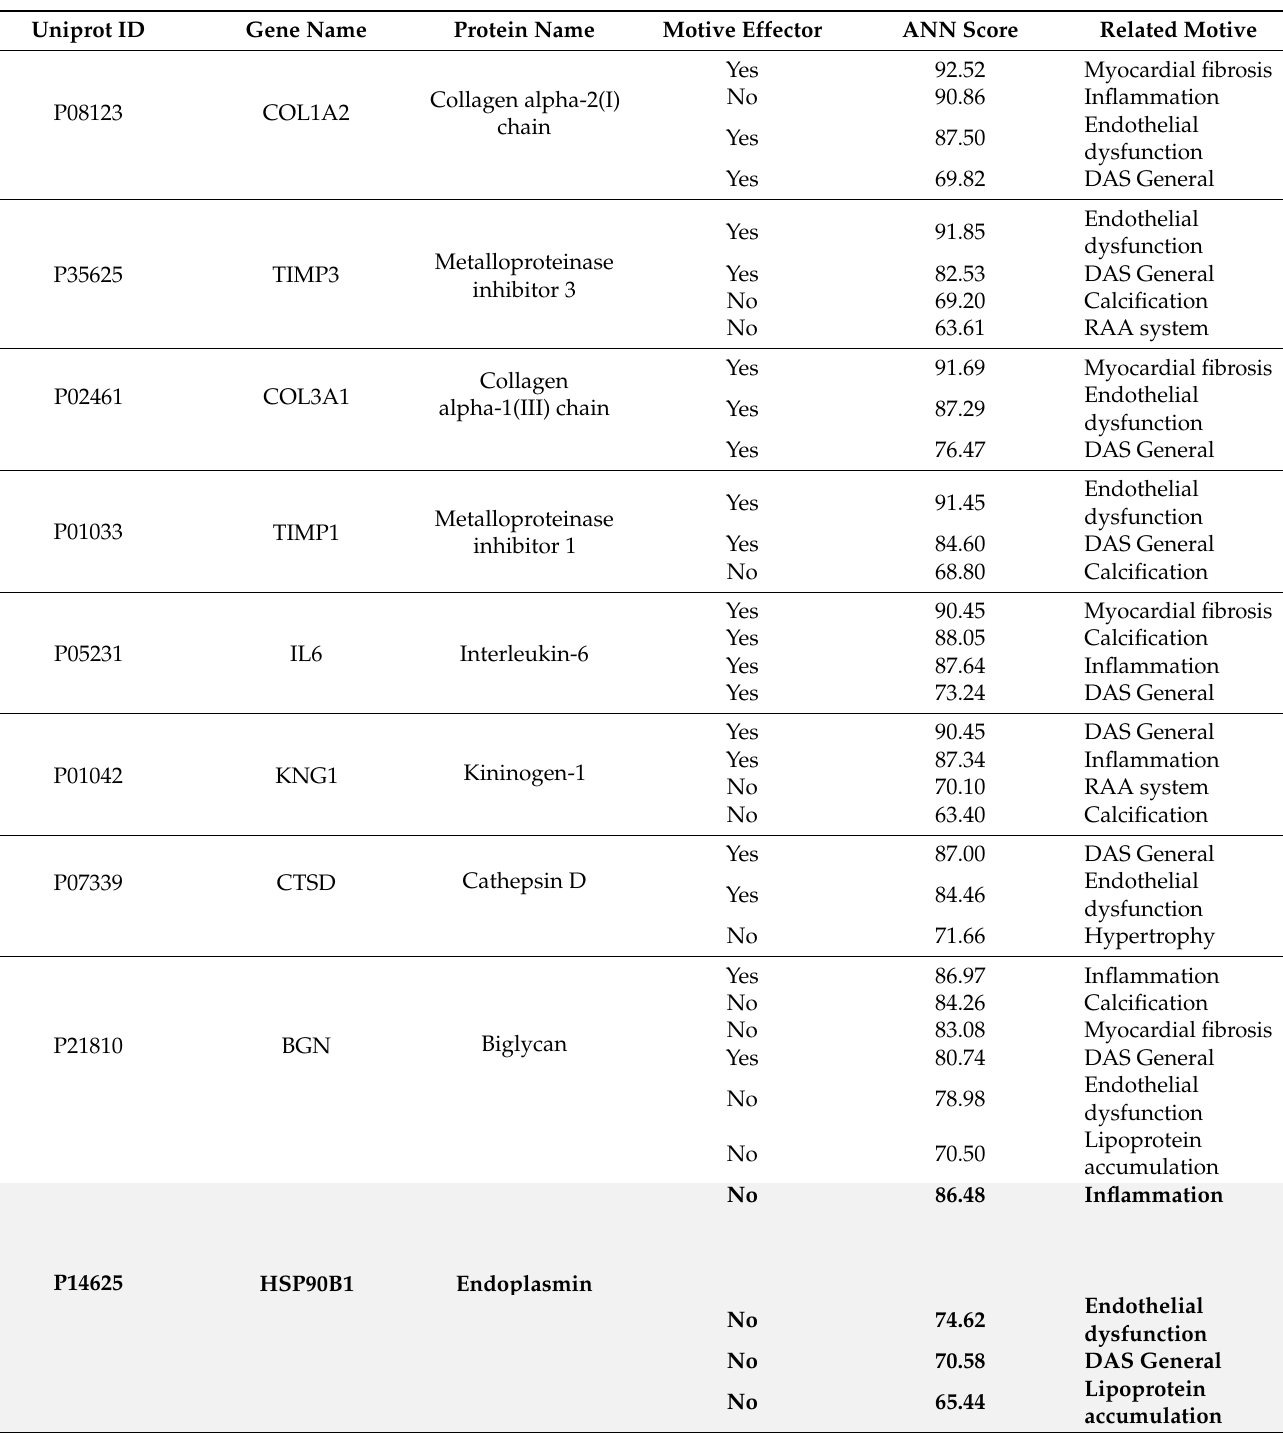
Table 5. Protein candidates that display a strong relationship with at least 3 degenerative AS motives, arranged in decreasing order of the highest ANN score. Proteins that were not described in the molecular characterization and are not considered effector proteins are in bold and